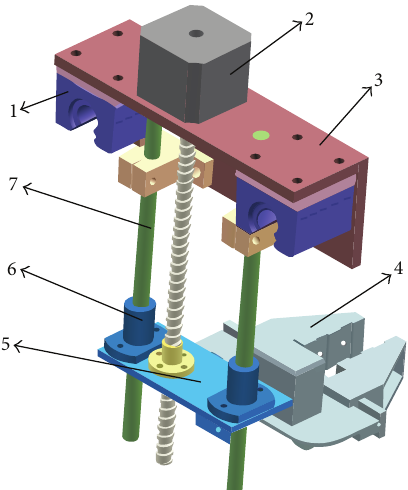
Figure 6: Structure of the clipping mechanism. 1: sliding unit, 2: screw motor, 3: connection base, 4: robot hand, 5: mounting base for robot hand, 6: linear bearing, and 7: bare guiding shaft.